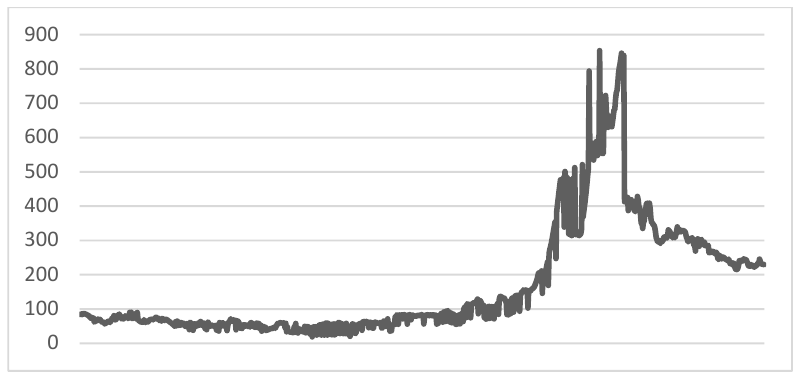
Figure 4. Fluctuations in the average closing prices of Indian fintech companies (authors calculation based on BSE stock prices).